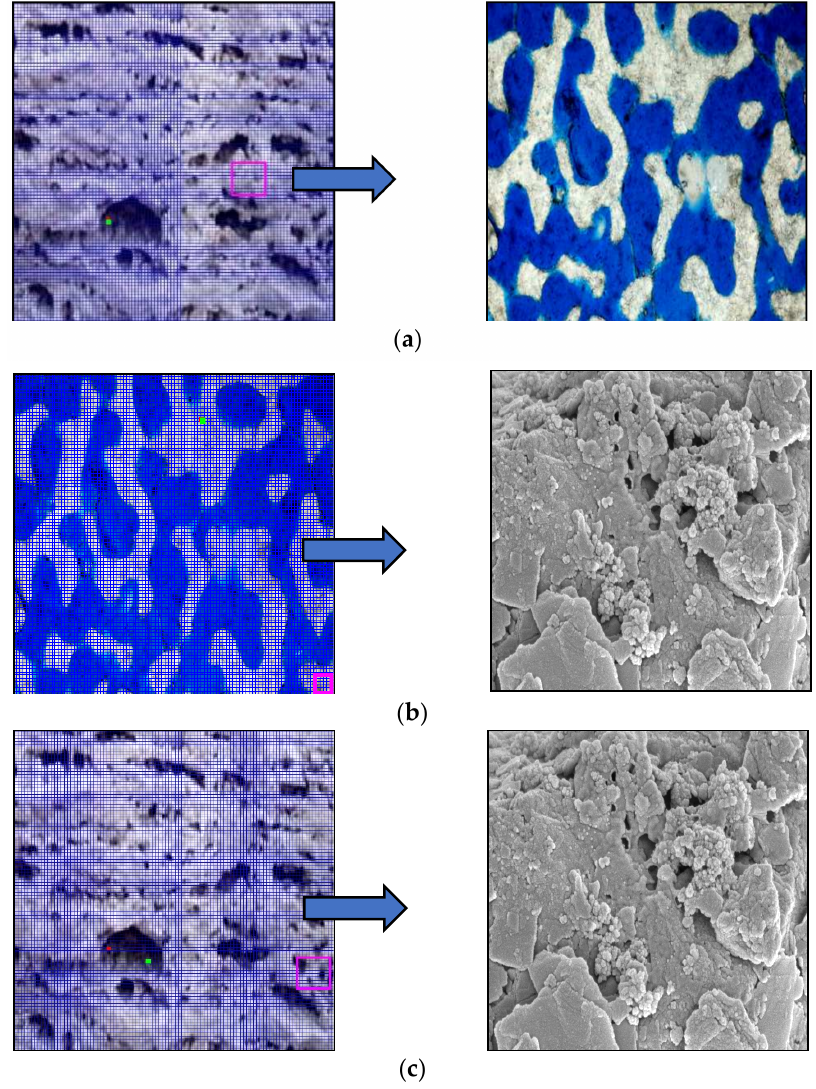
Figure 16. Comparison between search location area and real sampling area. ( a ) Macro mesoscopic search positioning comparison; ( b ) Meso–micro search positioning comparison; ( c ) Macro micro search positioning comparison.